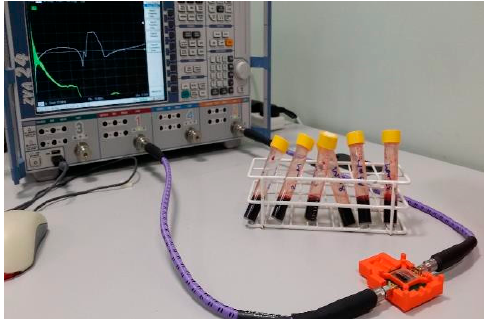
Figure 1. Experimental setup with VNA and 2-port EM sensor connected via coaxial cables.